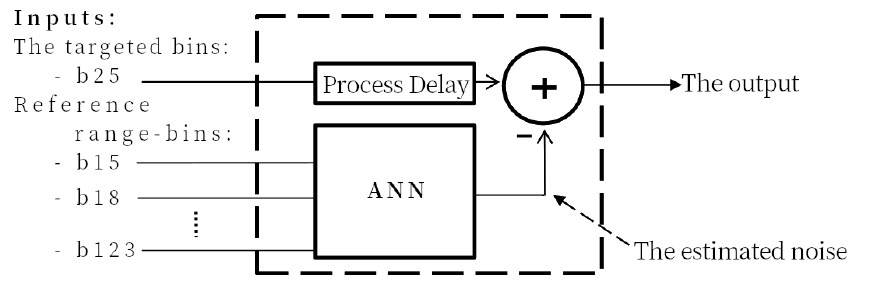
Figure 3. A block diagram for the SB-ANN interference (noise) estimation